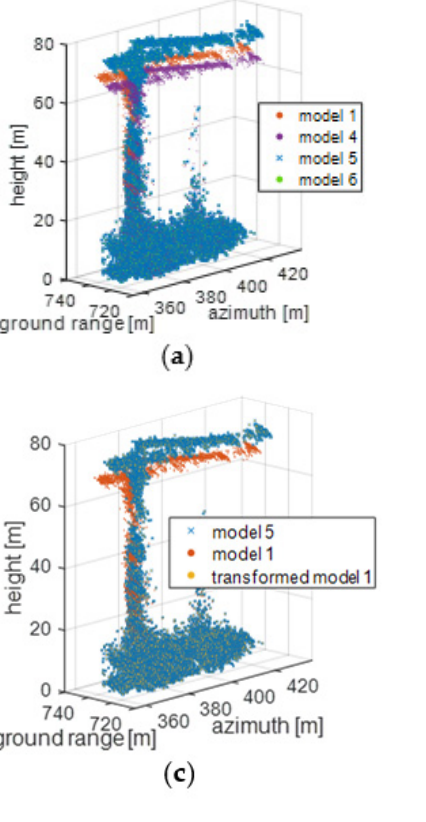
Figure 23. The reconstructed tower crane ( a ) under model 1 (the exact form of the planar wavefront model), 4 (the third approximate form of the planar wavefront model), 5 (the exact form of the spherical wavefront model) and 6 (the approximate form of the spherical wavefront model); ( b ) in the ground range – height plane; ( c ) under model 1, transformed model 1 and model 5; ( d ) under model 4, transformed model 4 and model 5.